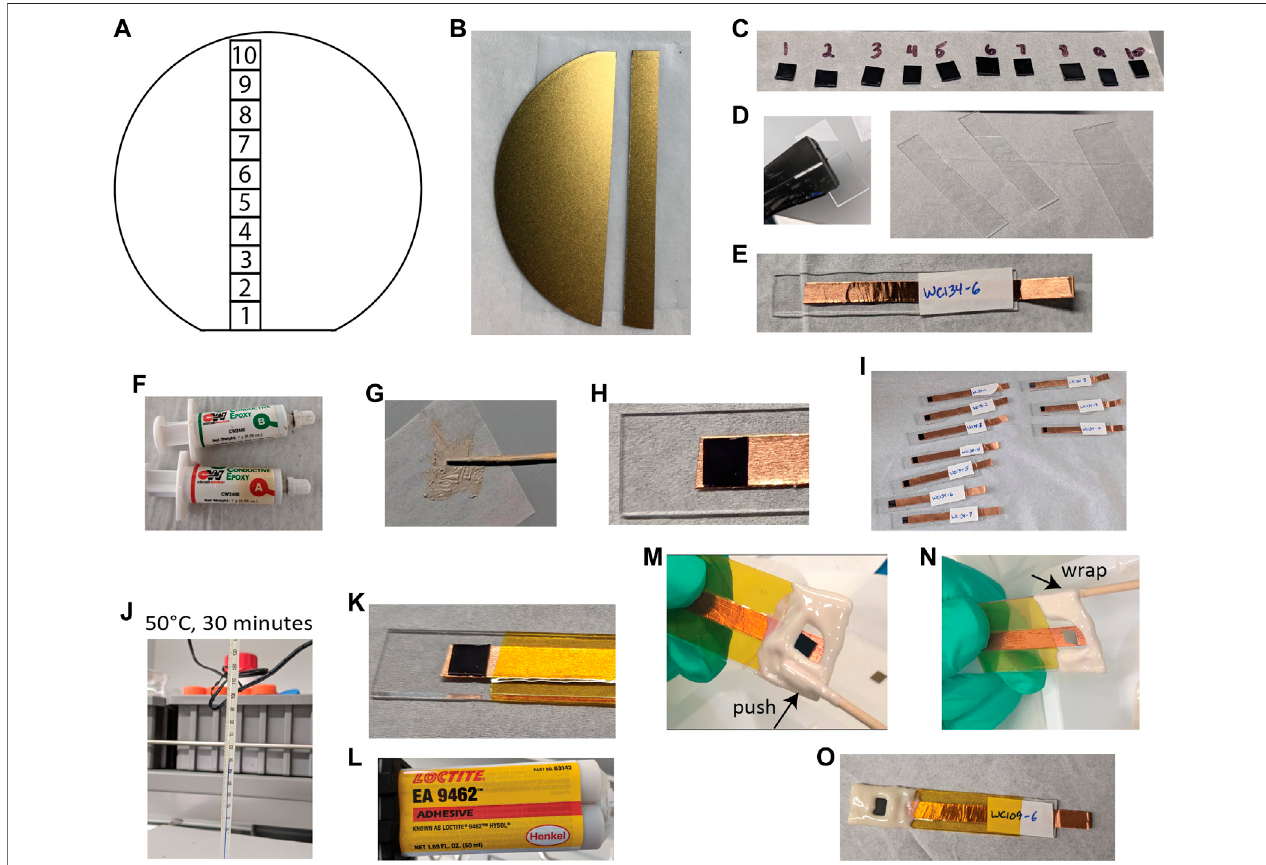
FIGURE 2| Photoelectrode preparation. (A) Schematic ofa 2 ″ wafer showing ten 5 × 5 mm squaresin a radial strip. (B) A 5 mm strip cleaved from a GaInP/GaAs wafer,showingbackohmiccontact. (C) 5×5 mmsquaresfromthewafer. (D) Runningpliersandpreparedglassslidehandles. (E) Coppertapeandlabelappliedtoone handle. (F) CircuitWorks CW2400 silver epoxy. (G) Prepared silver epoxy. (H) 5 mm square adhered to copper tape with a small amount of silver epoxy. (I) Ten electrodes prepared for curing. (J) Electrodes are cured at 50 ° C for 30 min. (K) Kapton tape added to cover most of the exposed tape. (L) Loctite EA 9462 epoxy. (M , N) De fi ning surface area and sealing photoelectrode edges. (O) Completed electrodes after 24 h of curing EA 9462